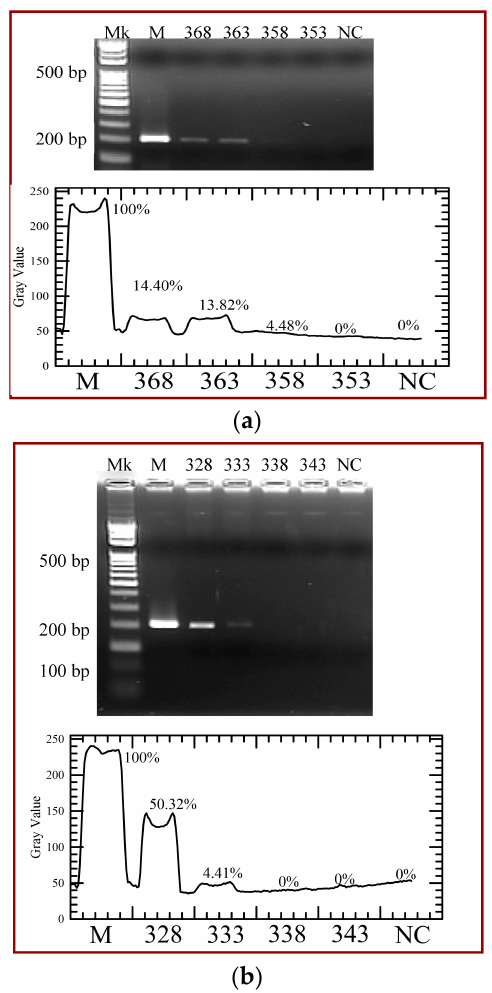
Figure 13. Agarose gel electrophoresis of the polymerase chain reaction (PCR) yield with ( a ) various heater temperatures for 368 K, 363 K, 358 K and 353 K and ( b ) various temperatures of the Peltier element for 328 K, 333 K, 338 K, and 343 K. The gray intensities of PCR products are created by image analysis.